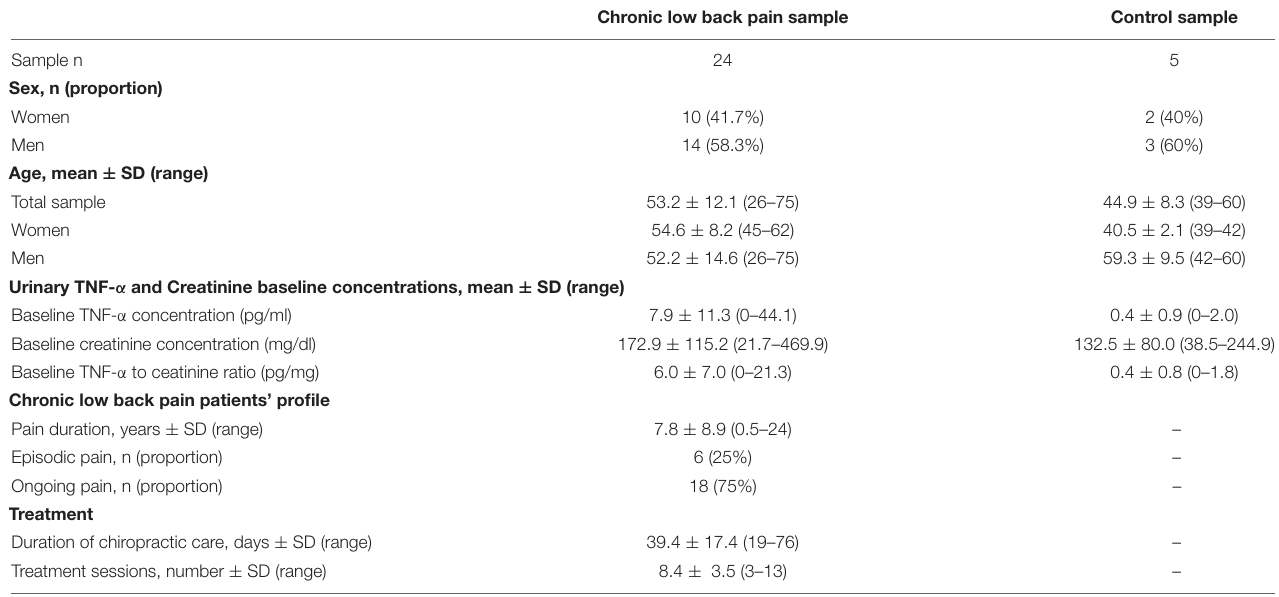
TABLE 2 | Participant demographic and baseline data.